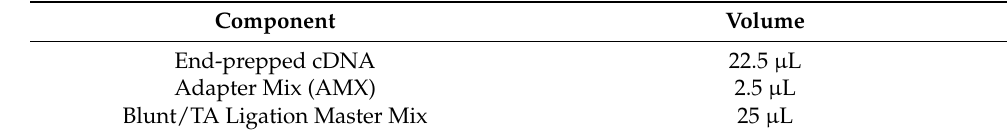
Table 9. Adapter ligation reaction